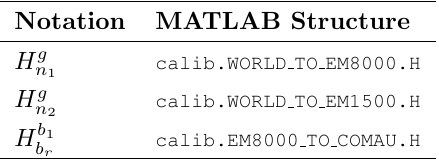
Table 5: Fixed homogeneous transformations obtain- able from the calibration MATLAB structure found from loading the calibration file.